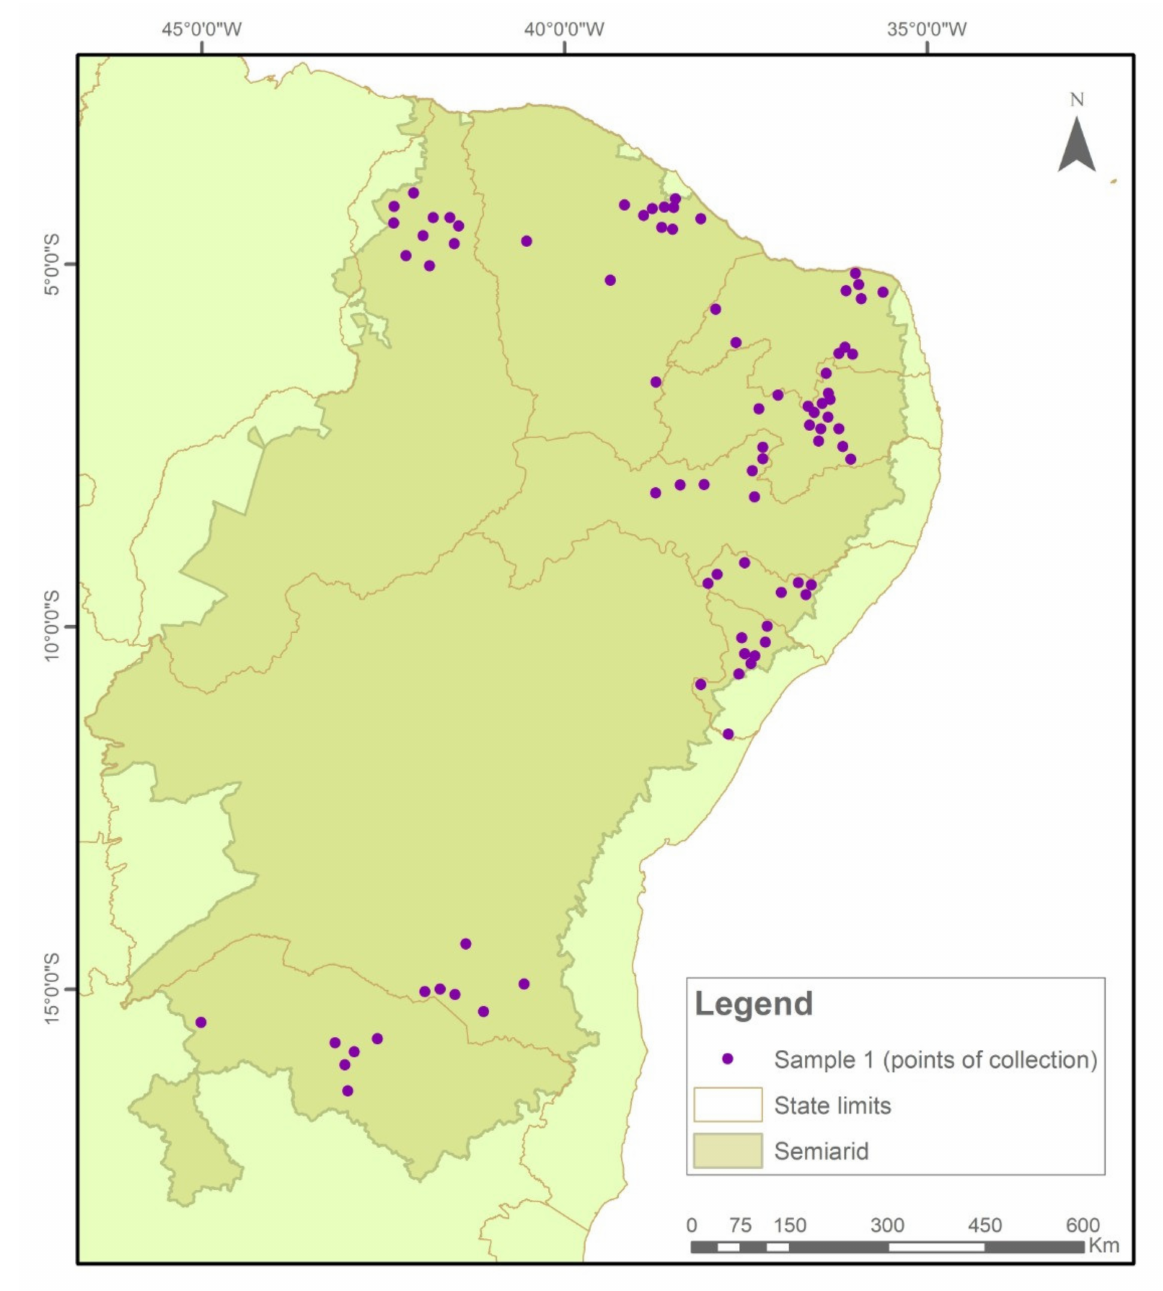
Figure 7. Indication of seed sample collection points in municipalities in the Brazilian Semi-arid Region,